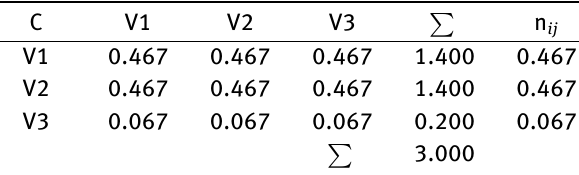
Table 7: Comparison of variants in accordance with knowledge transferring eflciency.